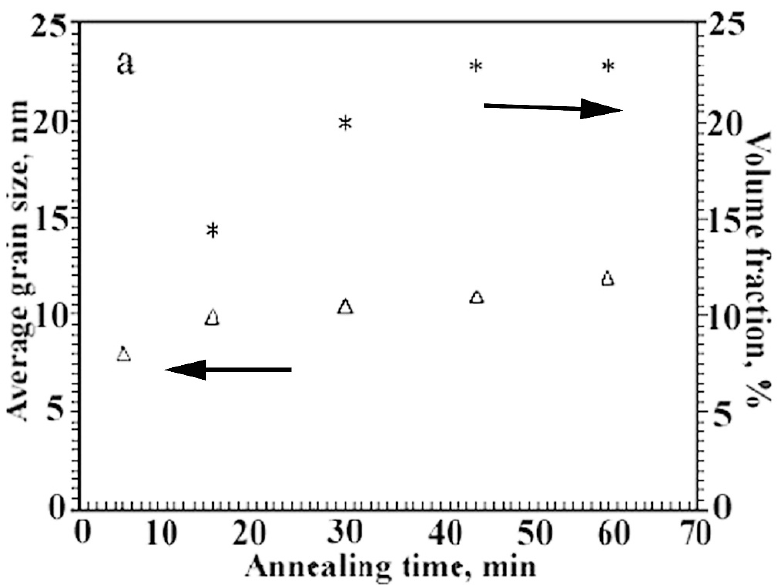
Figure 6. Dependence of an average nanocrystal size (triangles) and fraction of the nanocrystals (asterisks) on the duration of annealing at 473 K for Al86Ni11Yb3 sample [59] [reproduced from Physics of The Solid State 2001, 43, 2003 with permission from Pleiadis Publishing, 2020].